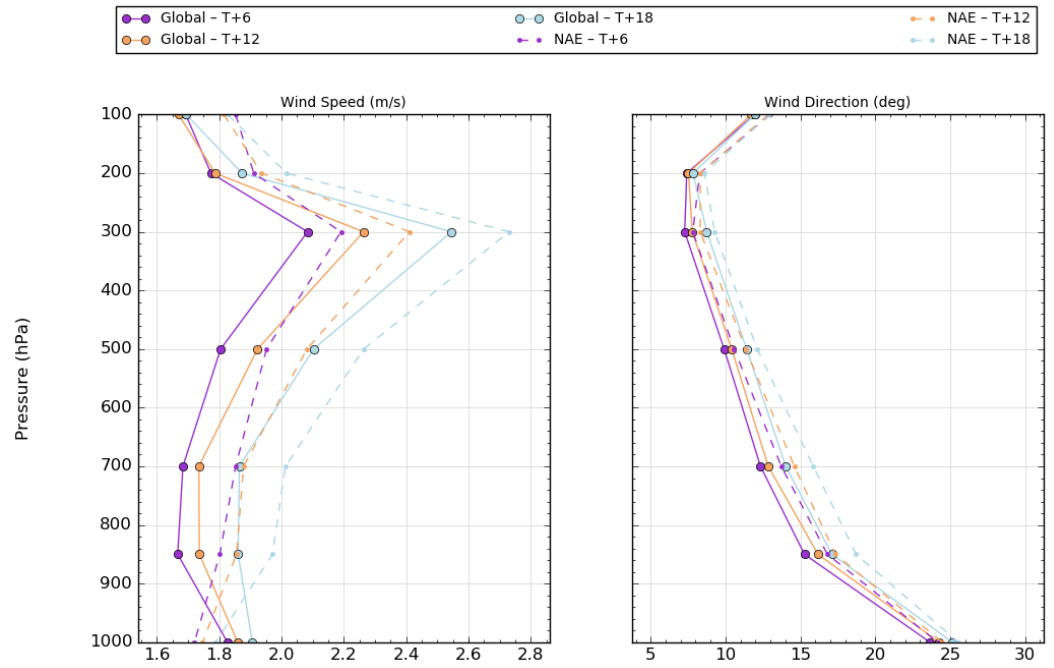
Figure 2. Vertical profiles of Mean Absolute Error, comparing the Global model and NAE model ( Left ) forecast wind speed and ( Right ) forecast wind direction to radiosonde data during